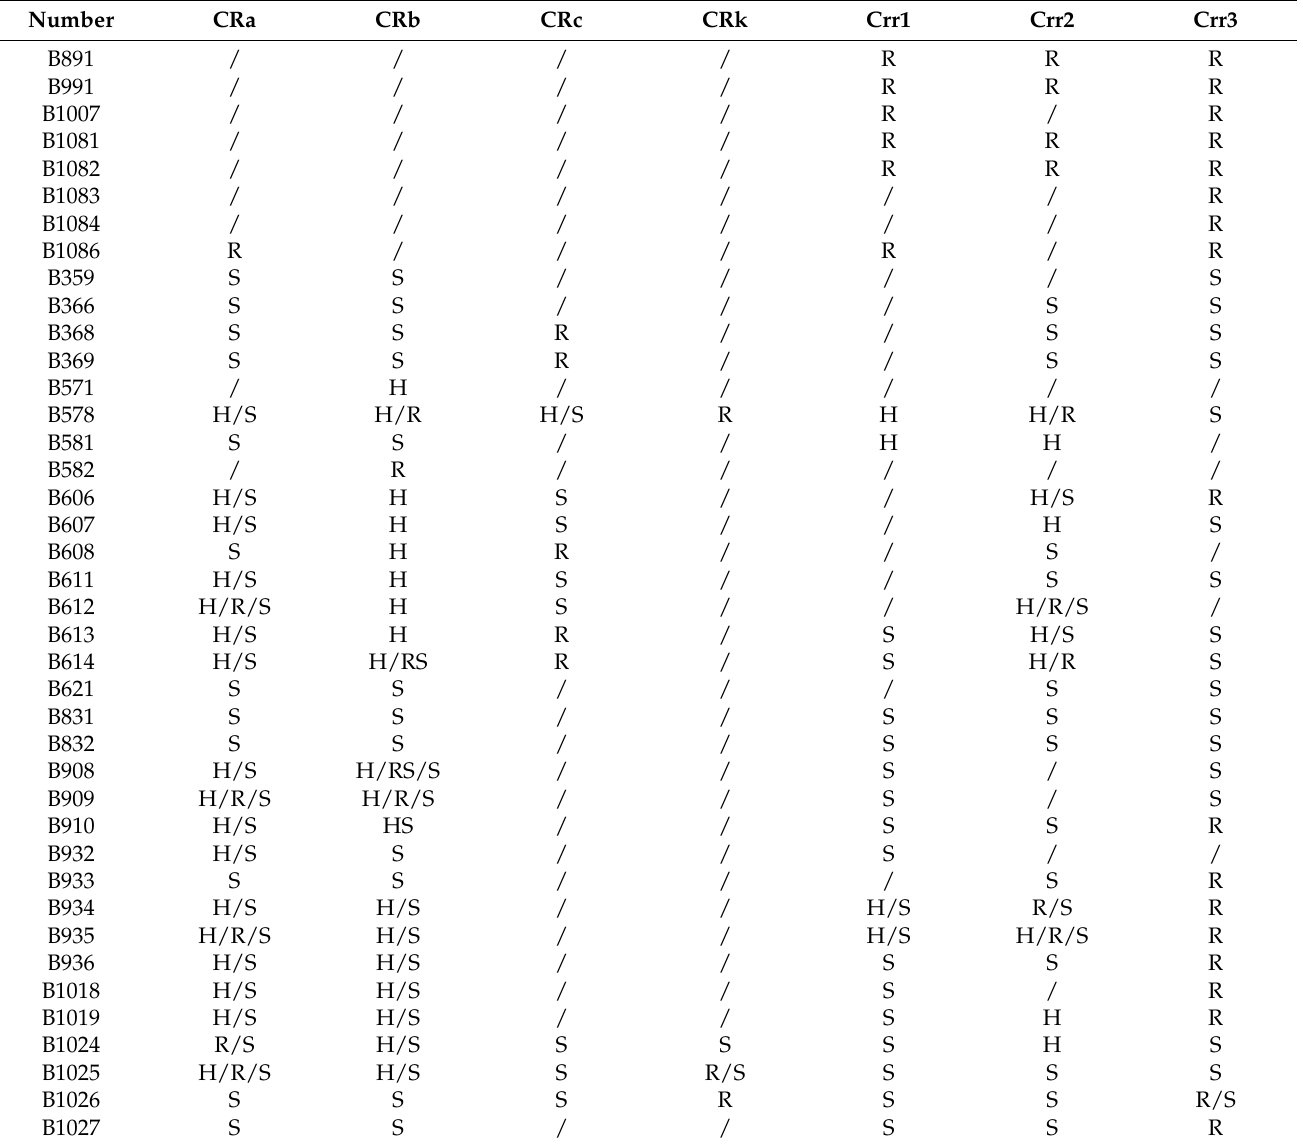
Table 4. Identification of 41 cruciferous genotypes by CR